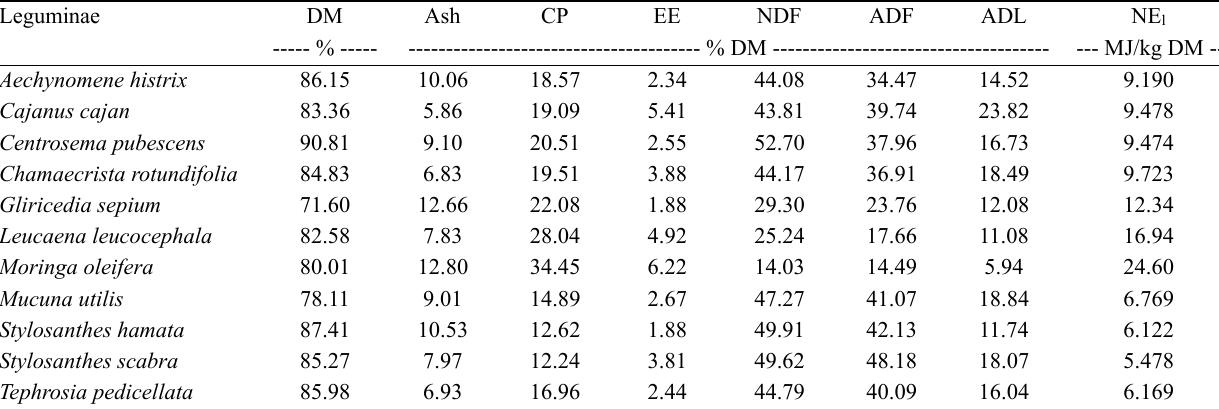
Table 2. Chemical composition and nutritive value of legume forages Leguminae DM Ash CP EE